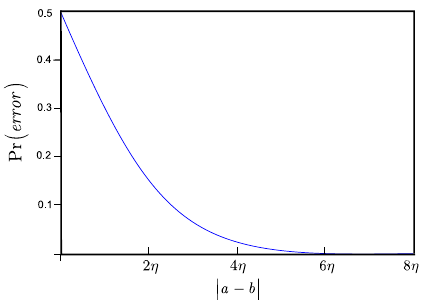
Figure 5. The error probability of the scalar reconciliation process. It converges exponentially to zero as | a − b | > 2 η